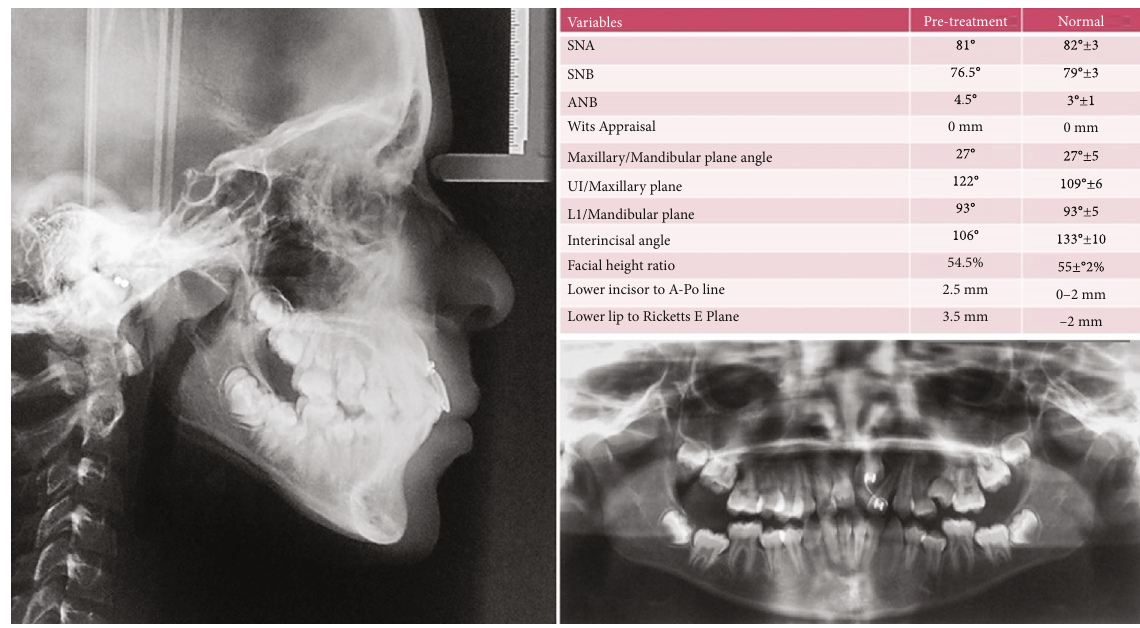
Figure 2: Pretreatment radiographs and